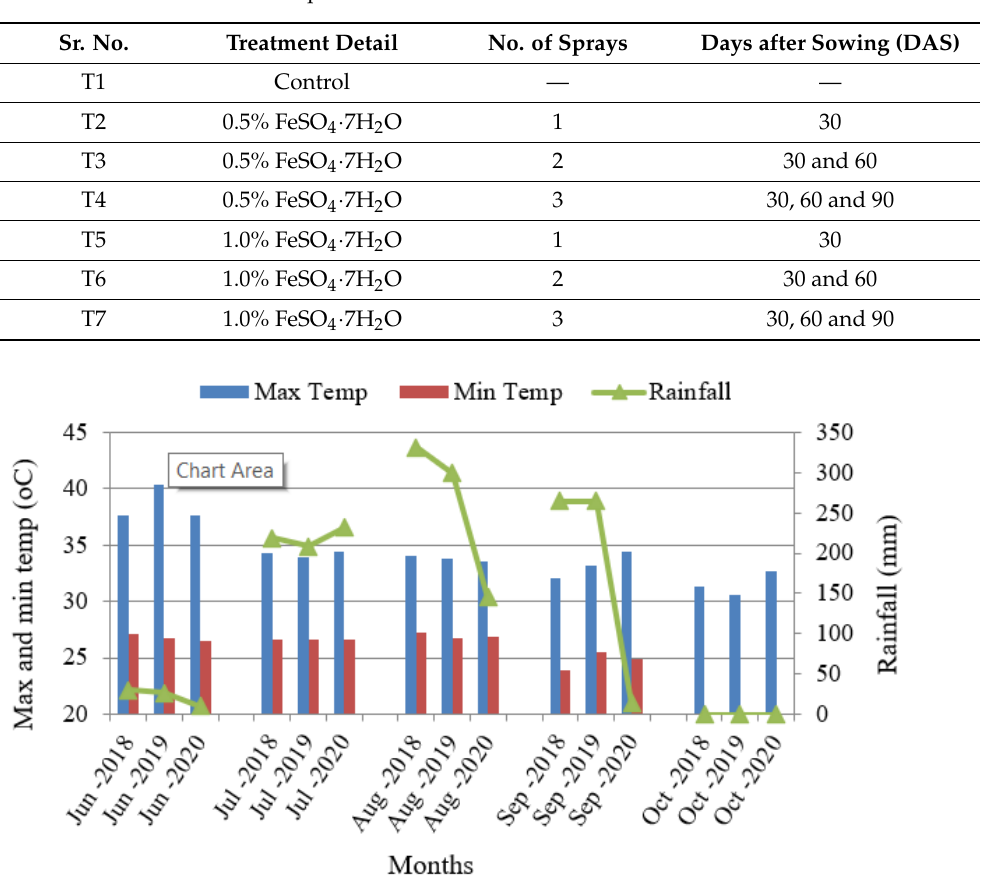
Figure 1. Monthly average maximum and minimum temperature as well as rainfall during the experimental period. Table 1. Treatment details of experiment at research farm of PAU